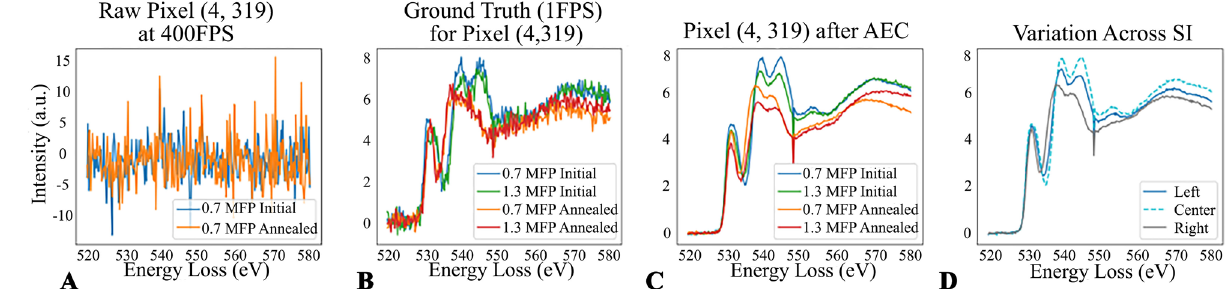
Figure 7. Spatial effects and fine details variation of predictions on the thin, initial state SI at 400FPS. ( A ) Comparison of the EELS data from an individual pixel ( B ) Corresponding Ground Truths for the different SI at